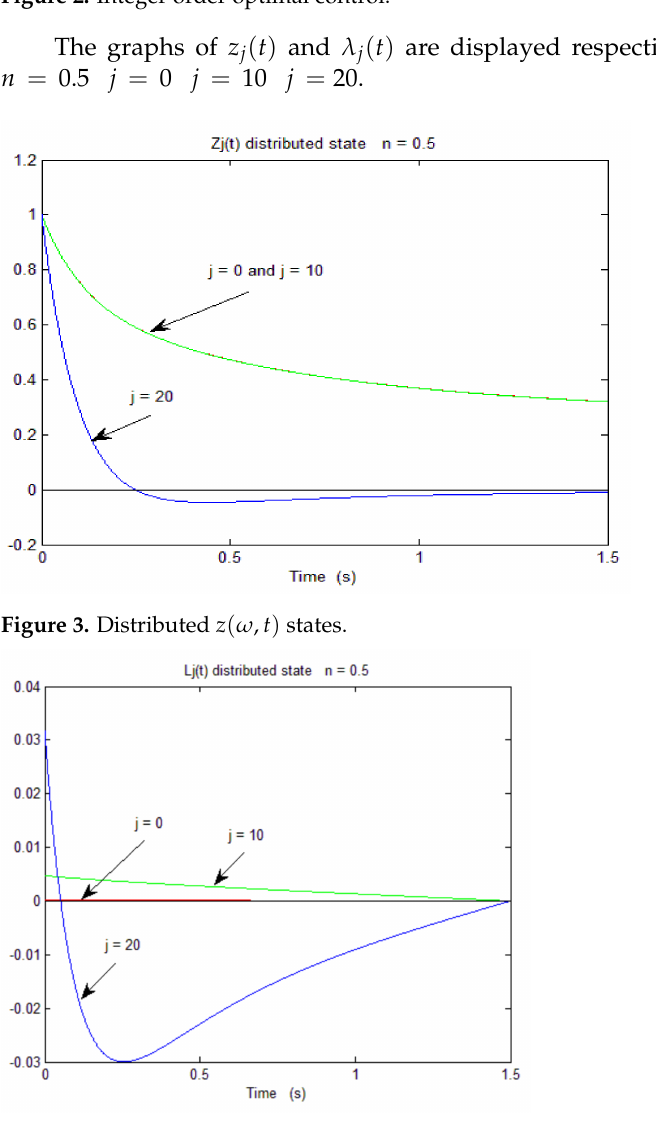
Figure 4. Distributed λ ( ω , t ) states. We can note that the graphs of z j ( t ) for j = 0 and j = 10 are very close, which is also verified in the graph of Figure 6 for n = 0.5: since z j ( 0 ) = 1 ∀ j and according to